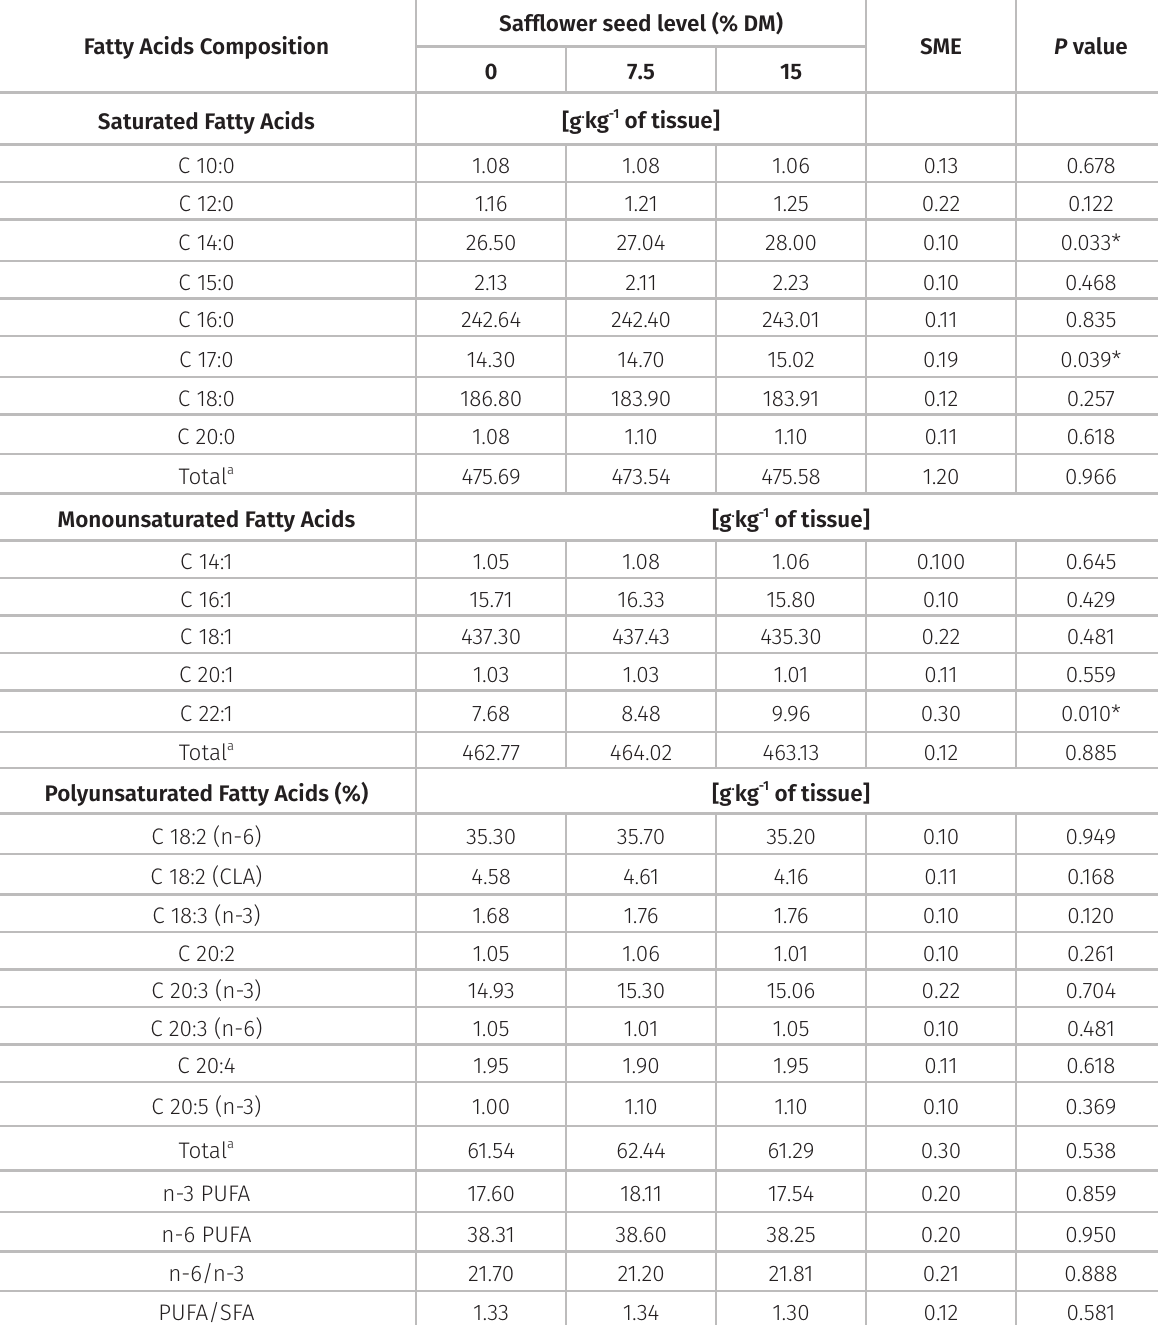
Safflower seed level (% DM)